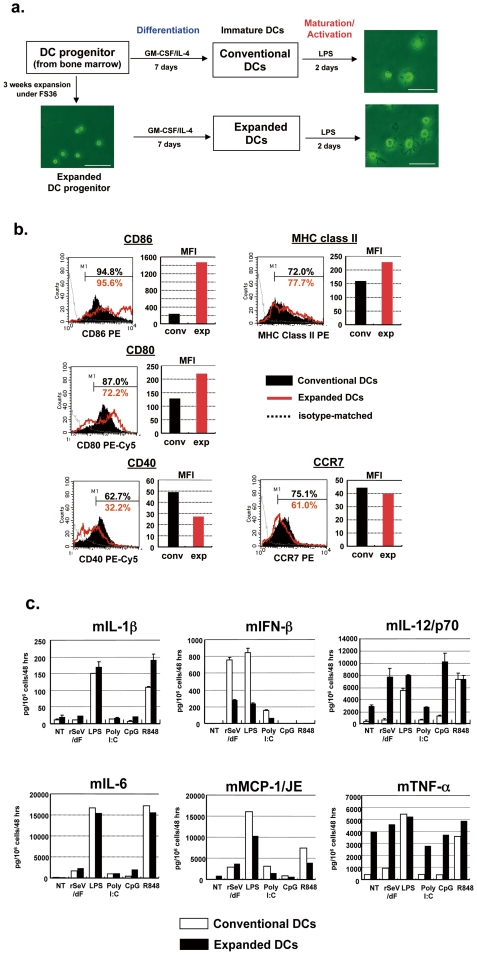

In vitro characterization of expanded murine DCs.a. Schematic diagram of expansion/differentiation/maturation/activation sequences and microscopic morphology of conventional and expanded DCs that were stimulated by LPS. Note that typical dendrites were found in both DCs. b. FACS analyses assessing the expression of typical surface markers. Conventional and expanded DCs after treatment with GM-CSF/IL-4 without further stimulus were subjected to FACS analyses. c. Expression of typical murine inflammatory cytokines/chemokines of conventional (open bars) and expanded (black bars) DCs in response to various stimuli for RIG-I helicase (rSeV) or Toll-like receptors (LPS for TLR-4, poly I:C for TLR-3, CpG-DNA for TLR-9, and R848 for TLR-7). The upper three panels (mIL-6, mIFN-β, and mIL-12/p70) were assessed by ELISA, and contain data from three independent experiments, and the bottom three panels (mIL-6, mMCP-1/JE, and mTNF-α) were performed using a Cytometric Bead Array (CBA) system and show one typical result taken from three independent experiments.